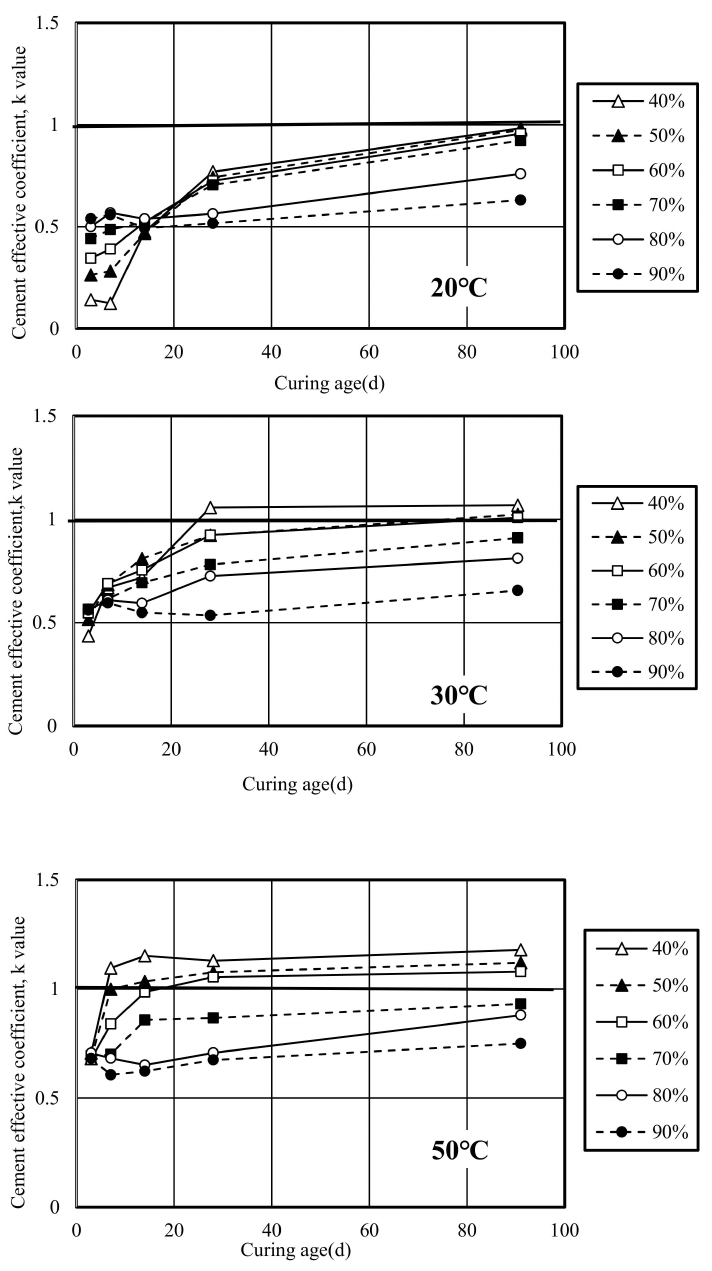
Figure 7. Cement e ff ective coe ffi cient-k value of slag mortar at di ff erent curing